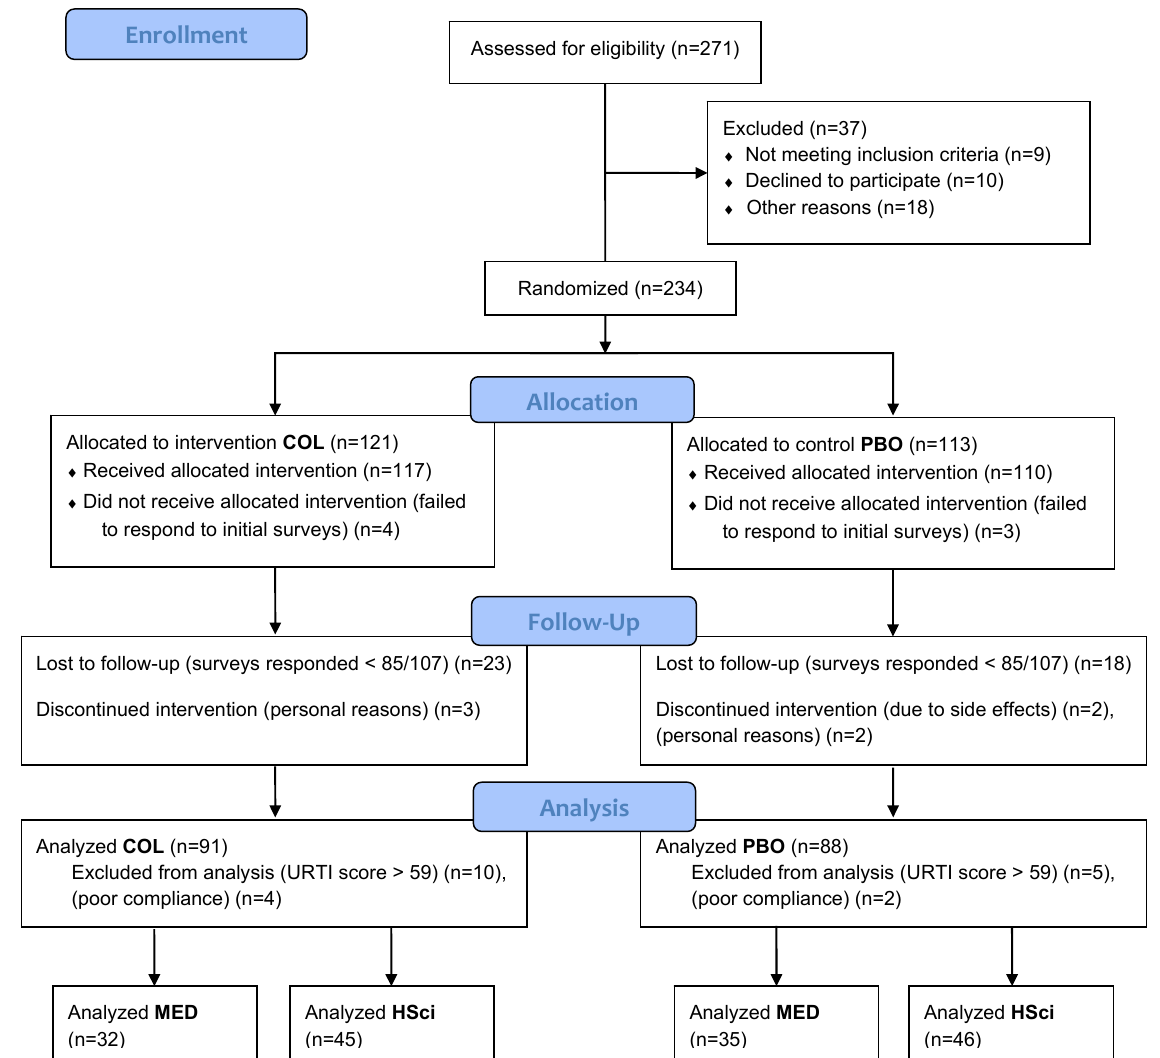
Figure 1. The CONSORT flow diagram.